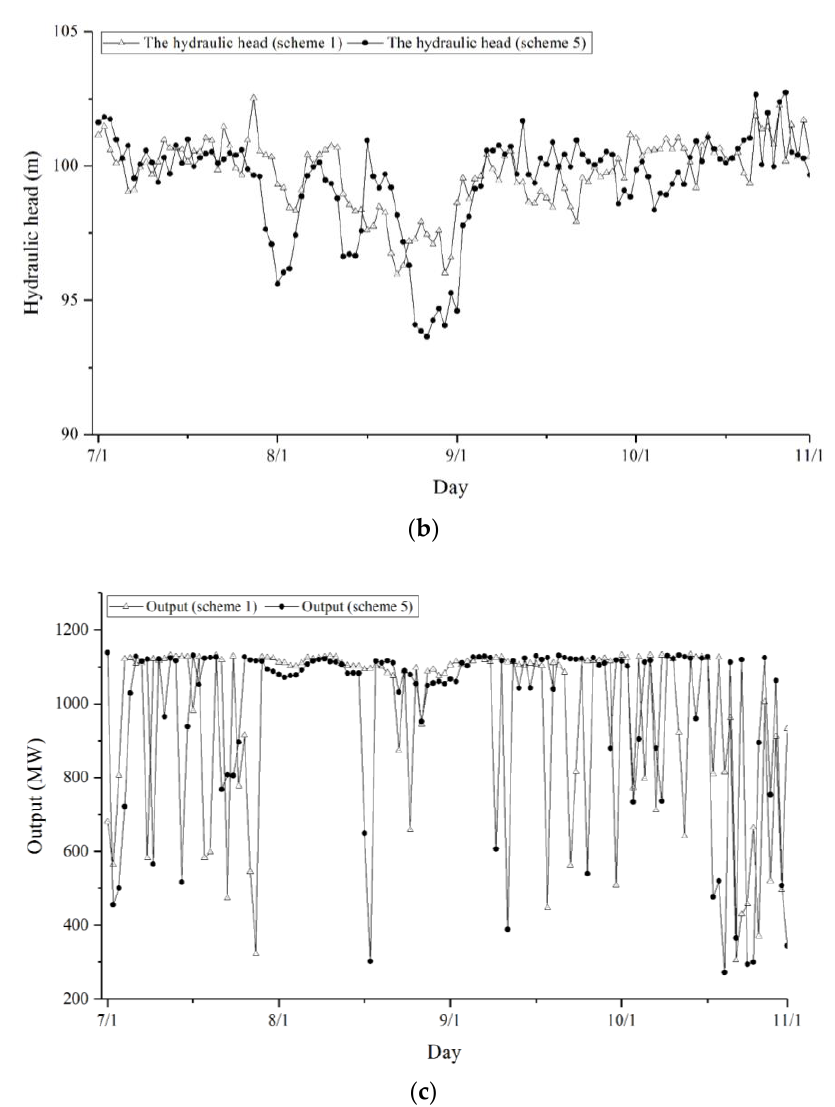
Figure 10. Generation change process from July to October in a wet year: ( a ) The generation flow process lines; ( b ) Hydraulic head change process lines; and ( c ) Output change process